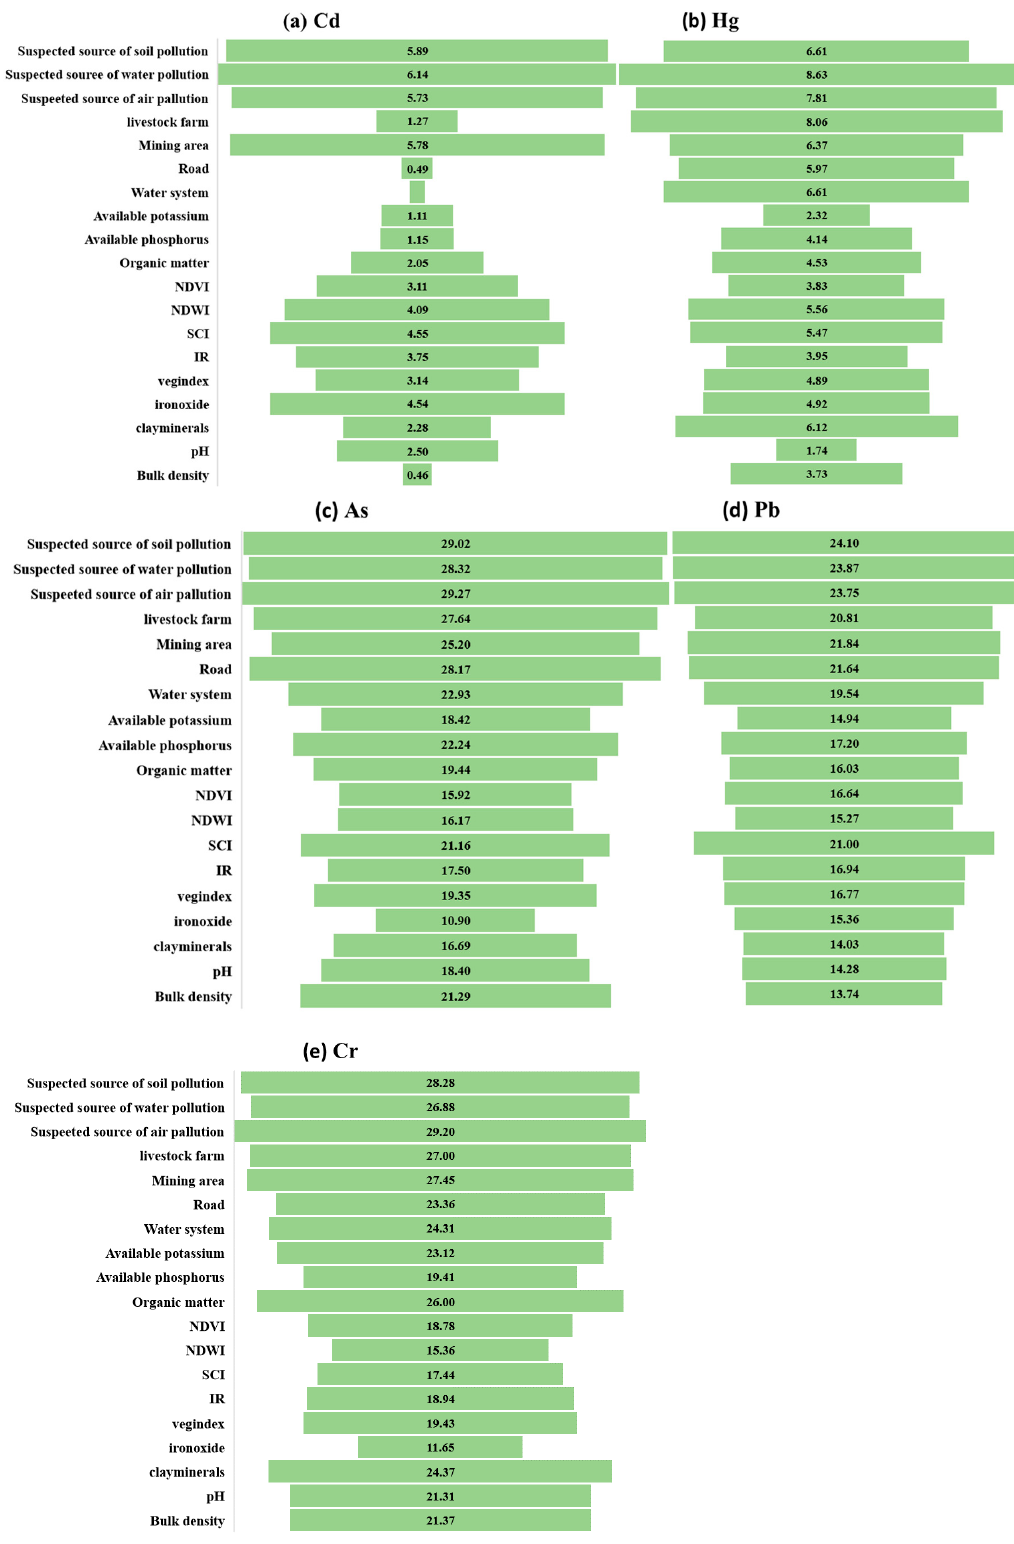
Figure 5. Plots of the variable importance measures (% increase in MSE) in Xiangzhou. ( a ) Cd; ( b ) Hg; ( c ) As; ( d ) Pb; and ( e ) Cr.